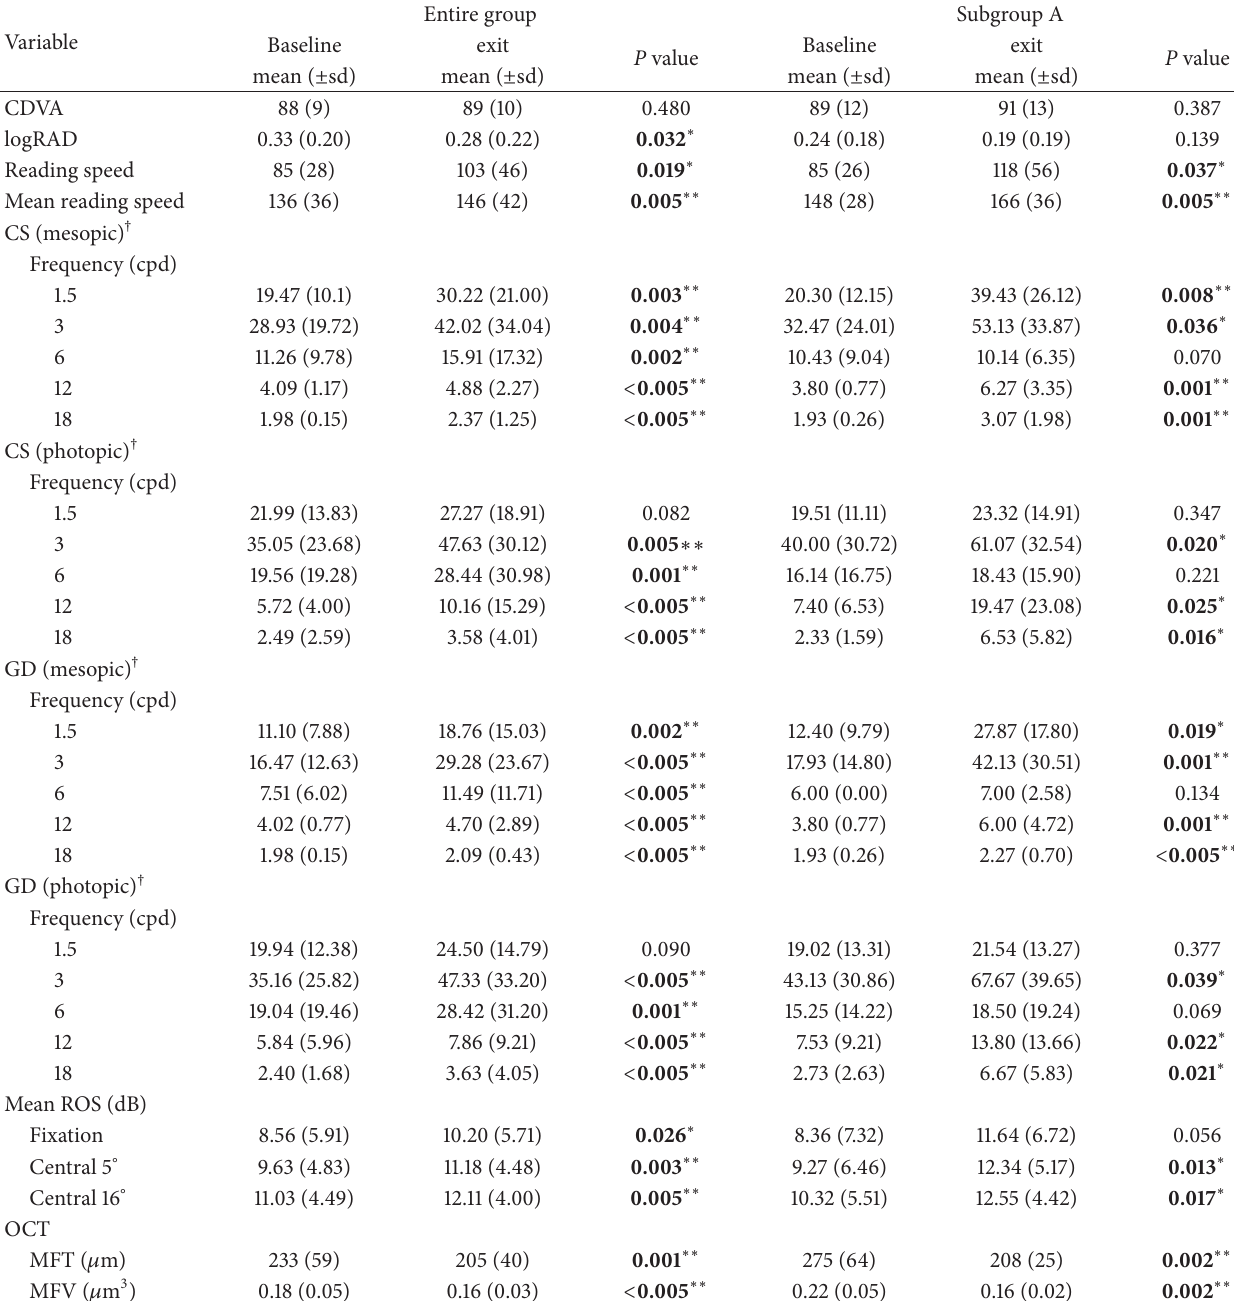
Table 1: Psychophysical data for study eyes in the entire study group and Subgroup A, between baseline and exit study